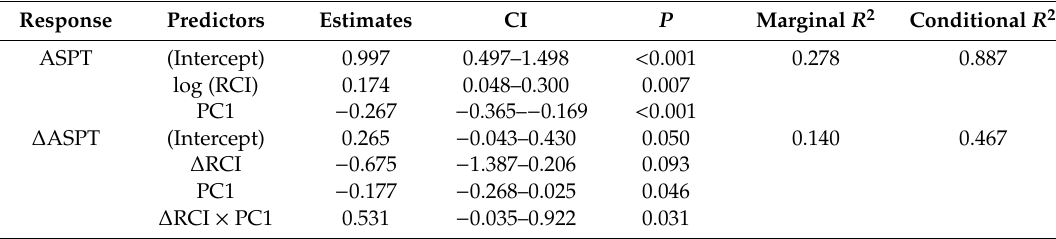
Figure 5. Mean log response ratios ( ± 95% CI) for each CROSSLINK case-study basin. These e ff ect sizes show the change between downstream sites bu ff ered with woody riparian vegetation (i.e., forested) and upstream sites without this type of bu ff er for each attribute used in the Riparian Condition Index. Table 4. Results from mixed models testing the influence of the Riparian Condition Index (RCI) on the macroinvertebrate Average Score Per Taxon (ASPT) index whilst controlling for catchment human impacts (PC1). The second model use log response ratios to describe the magnitude of change in the response ( ∆ ASPT) and predictor ( ∆ RCI) variables between site-pairs (i.e., unbu ff ered upstream sites and downstream, bu ff ered sites) whilst controlling for the existing level of ecological impairment (i.e., upstream PC1). PC1 is the Axis 1 sites scores from a Principal Components Analysis (PCA) explaining 37% variation in catchment-wide human impacts. CI, 95% confidence